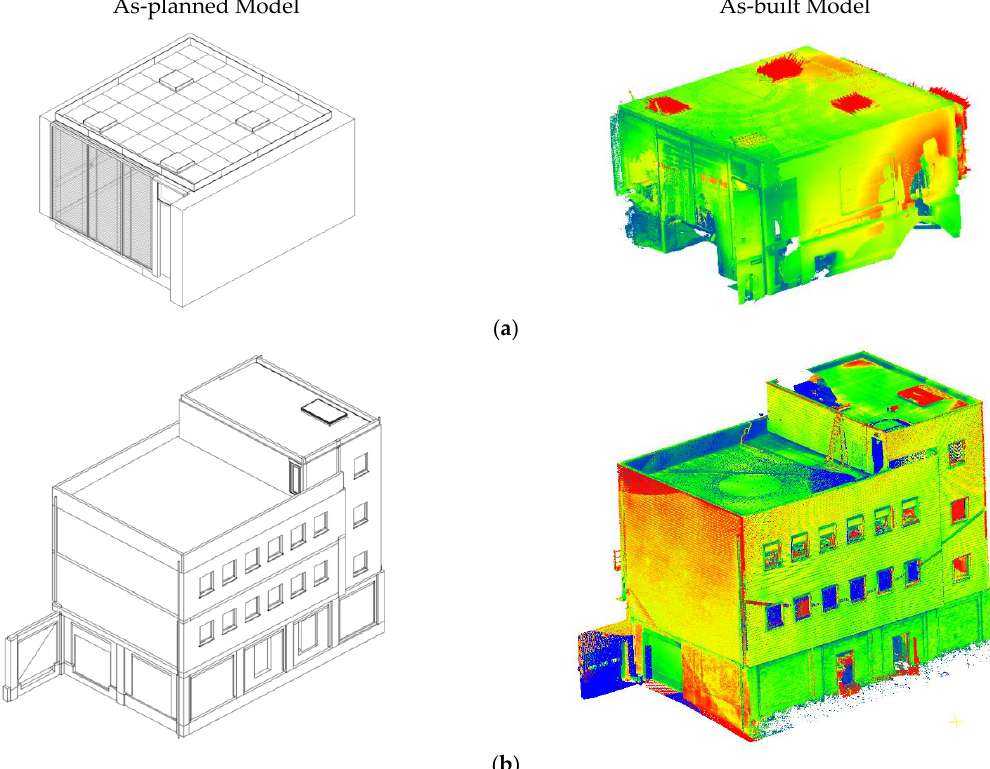
Figure 14 . Visualization of as-planned and as-built models for ( a ) dataset R1 and ( b ) dataset R2. During the testing, the initial down-sampling of the as-built models was performed with a voxel size of 0.2 m and, later, RANSAC-based-plane segmentation was performed to obtain as-built plane segments. Similarly, the number of RANSAC iterations to ran- domly select the two corner points from both models for identification of potential match- ing points was limited to 5000. Furthermore, according to errors in the as-built model of each dataset, a suitable tolerance value was used to verify the geometric invariants. The proposed method successfully registered all the datasets, as shown in Figure 15 . A detailed analysis was also performed to evaluate the registration accuracy and explore the limitations.